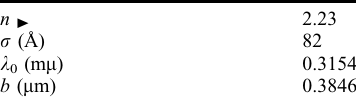
TABLEAU I Constantes Optiques de nos Couches Minces de TiO 2 Obtenues par la Me´thode des Interfe´rences Optiques.